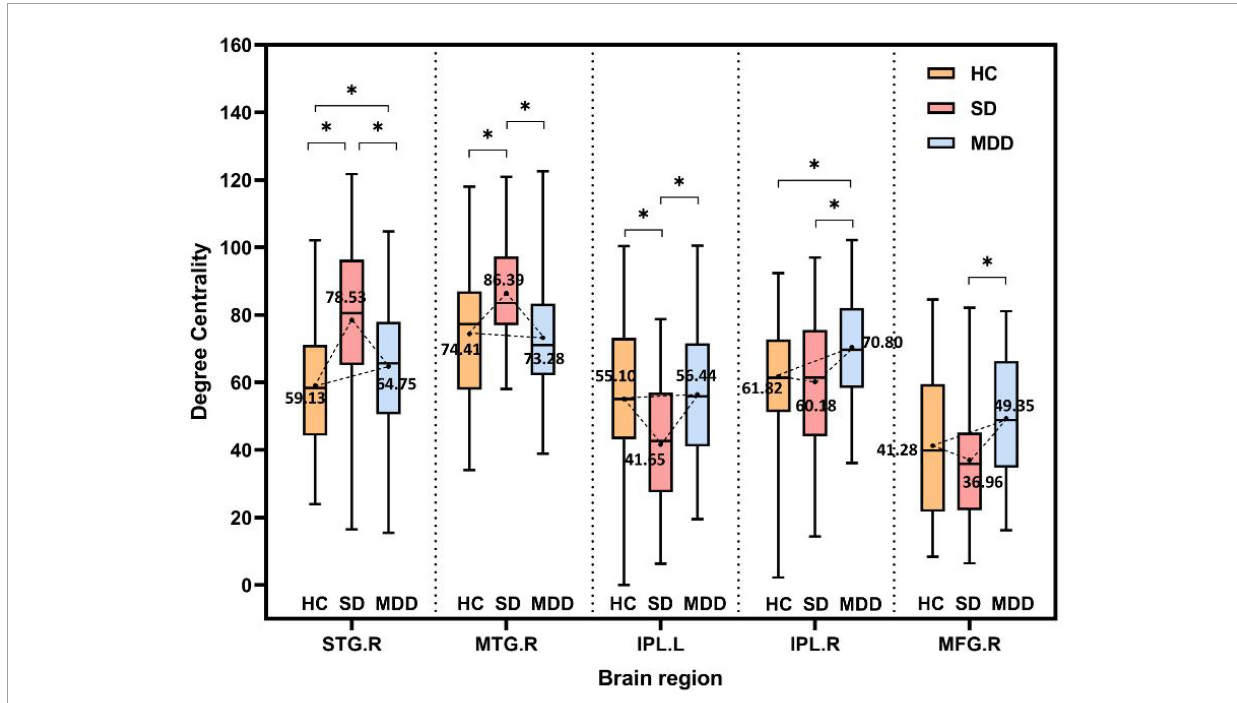
FIGURE4 The alteration tendency in DC between HCs, SD, and MDD for five important brain regions. “ ∗ ” indicates significantly different DC values between the two groups.